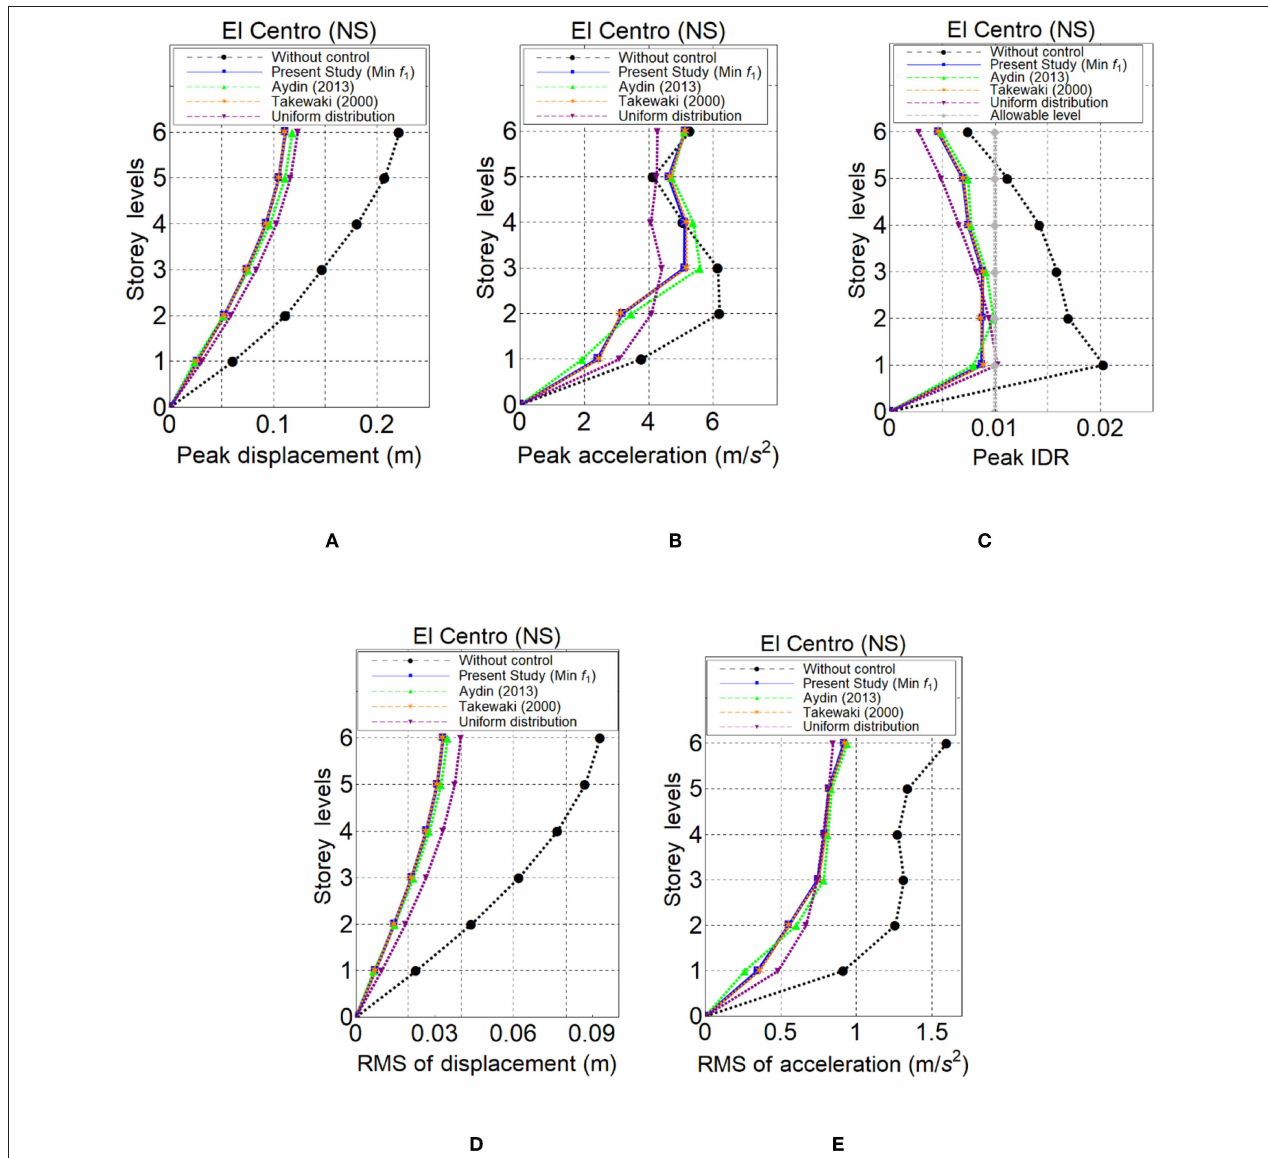
FIGURE 6 | Peak displacements (A) , peak absolute accelerations (B) , peak IDR (C) , RMS of displacements (D) , RMS of accelerations (E) based on f 1 and the methods of Aydin (2013), Takewaki (2000) and uniformly distributed VDs for El Centro (NS) ground motion.